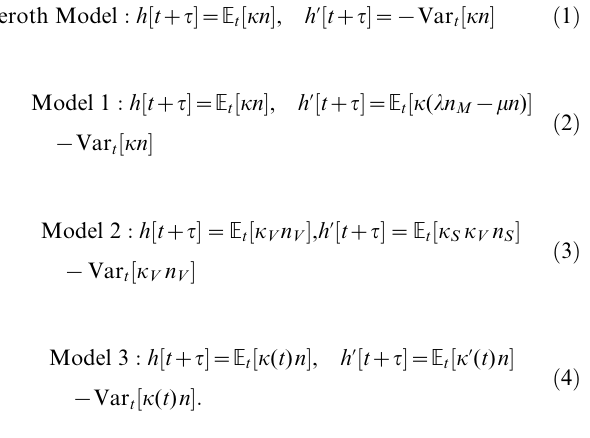
f t ½ t z t (cid:2) and h ½ t z t (cid:2) are expressible in terms of the model’s variables and parameters. Recall that n denotes the number of micrometastases. The expressions below are derived in File